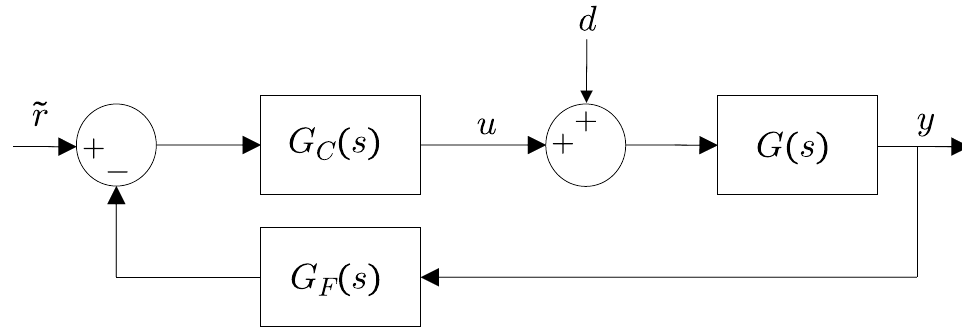
Figure 2. 2-degree-of-freedom (DOF) configuration of